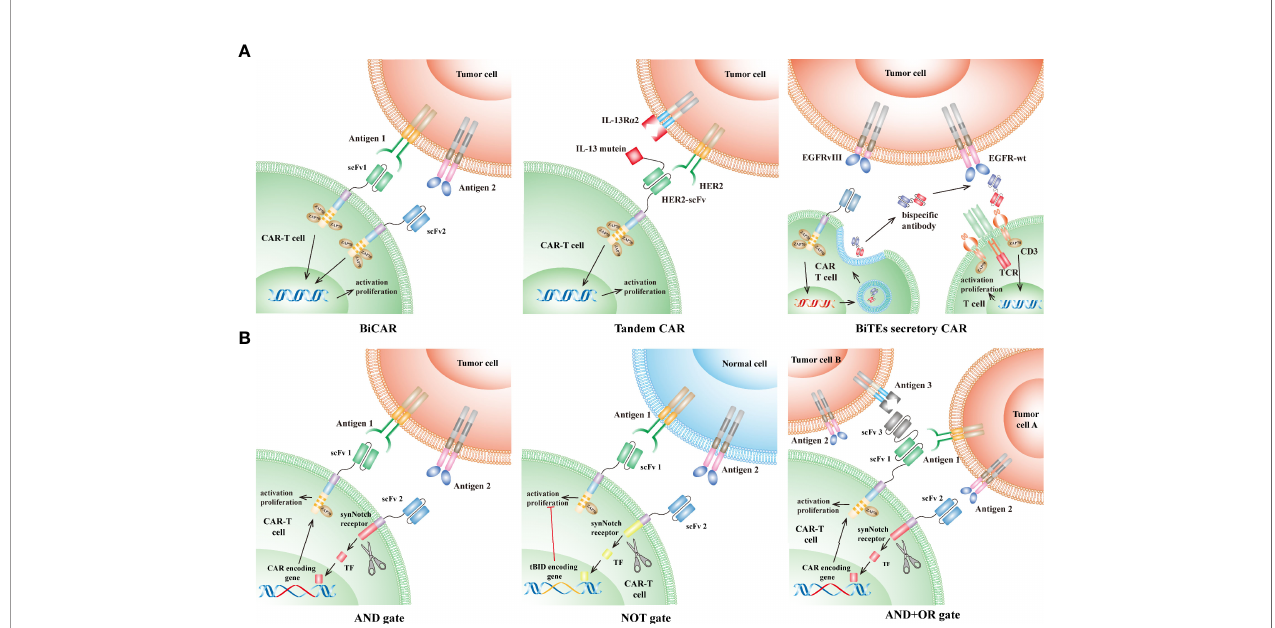
FIGURE 2 | CAR designs to overcome the GBM intratumor heterogeneity. (A) CAR targeting multiple antigens: (1) Bispeci fi c CAR (BiCAR, middle): BiCAR-T cells co-express two CARs that target different antigens on tumor cells. (2) Tandem CAR (Tan-CAR, right): Tan-CAR joins two antigen-binding domains to make a tandem CAR exodomain that can be activated by encountering either or both different antigens, e.g., HER2 and IL13R a 2. (3) Bispeci fi c T-cell Engagers (BiTEs) secretory CAR (left): BiTEs are composed of two distinct arms: one arm targeting the wild-type EGFR on tumor cells and another arm speci fi cally binding to the CD3 ϵ subunit on endogenous T cells. BiTEs-CAR T cells can directly kill tumor cells that express EGFR-vIII, while indirectly redirecting endogenous T cells to eliminate tumor cells expressing wild-type EGFR through secreting BiTEs. (B) Logic-gate principle: (1) “ AND ” gate (left): the intracellular domain of one CAR is designed as a synNotch receptor structure that is cleaved to form a transcription factor after engaging antigen 1 and subsequently initiate the expression of another CAR speci fi c for antigen 2. Thus, the tumor-killing effect can only be achieved when the CAR-T cells encounter tumors cells simultaneously expressing both antigen 1 and 2. (2) “ NOT ” gate (middle): similar to the “ AND ” gate design, except that activation of one CAR (targeting antigen 2) leads to suppressing the activation of another CAR (targeting antigen 1). Therefore, these CAR-T cells can be activated only if they encounter antigen 1 without the presence of antigen 2. (3) “ AND+OR ” gate (right): the fi rst CAR is designed as in the “ AND ” gate design, and the following expressed CAR is a TanCAR structure ( “ OR ” gate), which can be activated when it encounters antigen 1 or 3. CAR, chimeric antigen receptor; TCR, T-cell receptor; scFv, single-chain variable fragment; TF, transcription factor; tBID, truncated BH3 interacting death